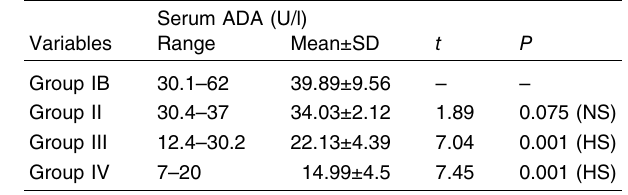
Table 5 Comparison between groups IB versus other groups as regard serum ADA Serum ADA (U/l) Variables